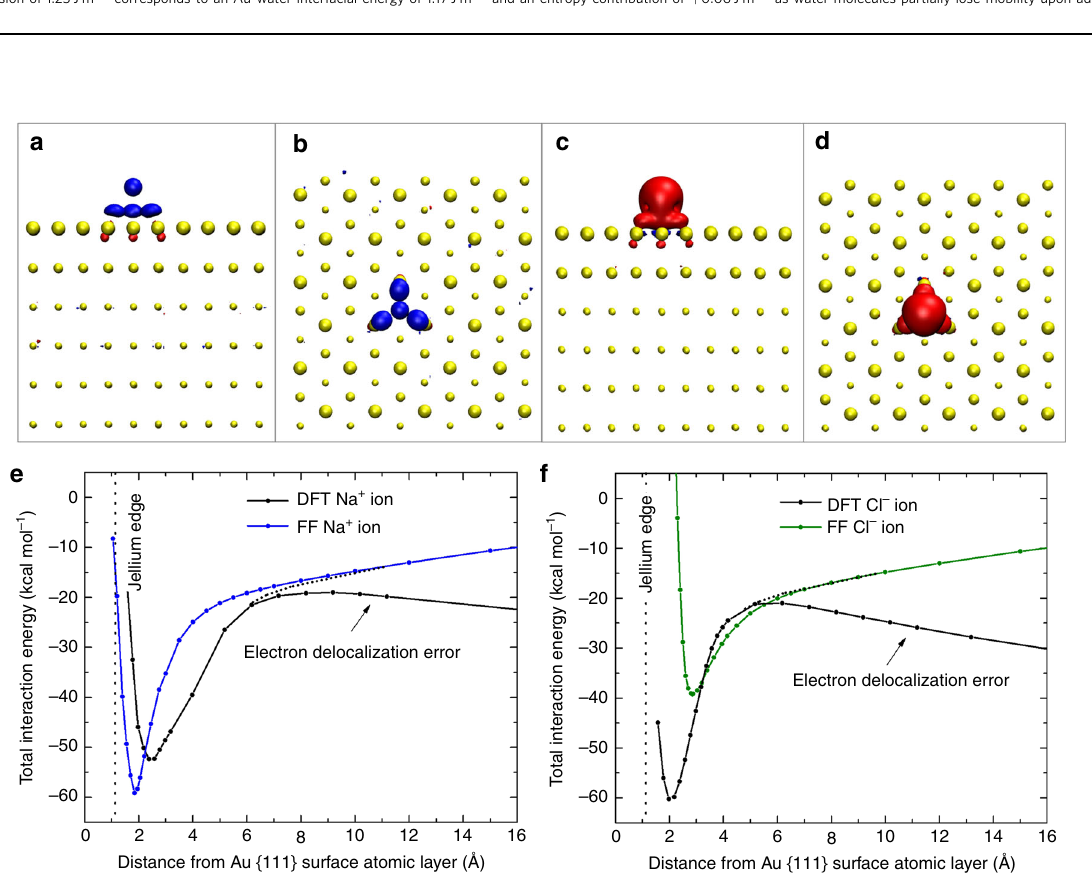
Fig. 3 Equilibrium position and total interaction energy of sodium and chloride ions on gold (111) surfaces in DFT calculations and with the polarizable force fi eld. a , b Na + ions are preferably located above epitaxial (hollow) sites in DFT calculations and in calculations with the polarizable FF. The contour of the electron density difference upon binding shows induced negative charge (blue) atop the surface atoms, similar to positions of dummy atoms (Fig. 1b) (contour level 0.02e Å − 3 ). c , d Cl − ions preferably bind to epitaxial (hollow) sites, too, in DFT calculations and with the polarizable FF. The contour of the electron density difference upon binding shows induced positive charge (dark red) atop the surface atoms (contour level 0.02e Å − 3 ) and some negative charge in the plane of surface atoms. e , f Total interaction energies of Na + and Cl − ions. Similar curves are seen for sodium ions ( e ) in DFT calculations and with the polarizable FF. Differences are noted for chloride ( f ). The larger chloride ion approaches the Au surface very closely in DFT, possibly due to chemisorption, which is neglected with the force fi eld. DFT does not reproduce long-range features (>5 Å distance) of the image potential that decay as 1/ r with distance r . Therefore, the vertical position of the DFT curve remains uncertain. Small identical simulation boxes of 1.44 × 1.50 × 10.0 nm 3 and a series of energy minimizations were employed to obtain both types of data speci fi c at distances below ~5 Å distance from the jellium edge Electrical monopoles from single ions cause signi fi cant long- (Fig. 2b and Supplementary Note 6 for details). A large range interactions, and convergent computations of the electro- improvement in comparison to the non-polarizable model is static attraction to the metal surface in vacuum require seen, and details of the individual energy contributions including suf fi ciently large 3D periodic boxes with recommended dimen- bond stretching are shown in Supplementary Fig. 3. sions of at least 10 × 10 × 100 nm 3 . Interactions between the